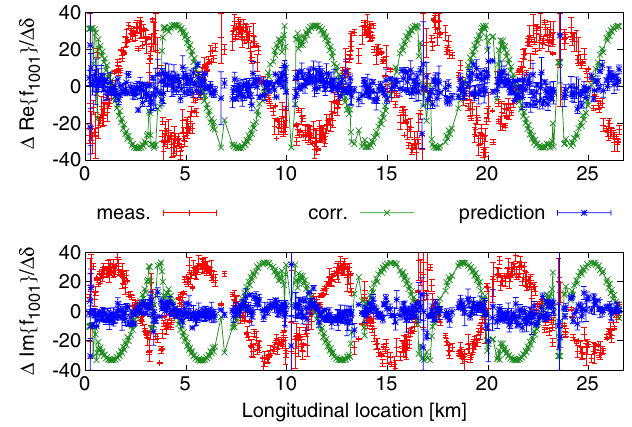
FIG. 6. The measurement (red), correction (green), and pre- dicted chromatic coupling after correction (blue), for beam 1 at 4 TeV and a (cid:1) (cid:10) of 60